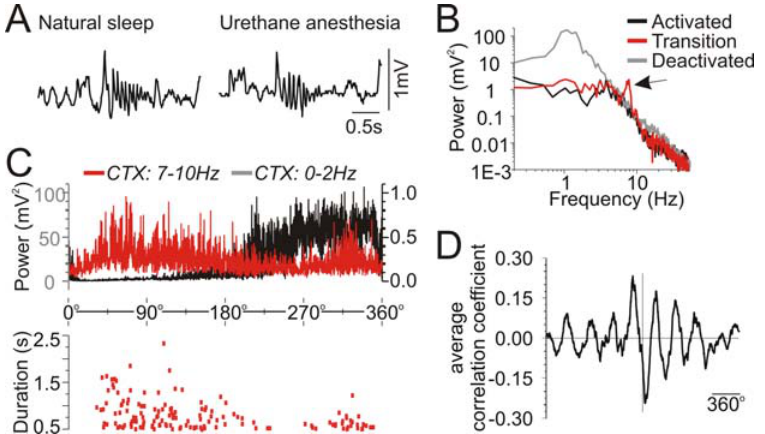
Figure 5. Transition phase between activated and deactivated patterns was characterized by cortical spindling across both natural sleep and urethane anaesthesia. A) An expanded example of a cortical spindle oscillation recorded during natural sleep (left) and a similar pattern recorded at the same electrode during the transition phase under urethane anaesthesia (right). B) Superimposed spectral plots of cortical EEG taken during activated, transition and deactivated states in a urethane-anaesthetized animal. Note the spectral peak in the transition spectra centered at , 8 Hz (spindle frequency). C) Superimposed spectrographic power at low (0 to 2 Hz: black) and spindle (7 to 10 Hz: red) frequencies (top panel), and the simultaneous occurrence and duration of spindles across the evolution of all state alternations for one full experiment (bottom panel). Note the augmented presence of spindling activity at the transition points between activated and deactivated patterns. D) Average (across all experiments) of the cross correlation function between 1 Hz and spindle (7–9 Hz) spectrographic power (n=5; standardized cycle in degrees). The temporal relationship of spindling to slow oscillatory activity at 1 Hz patterns showed a consistent lag of approximately half a period length ( , 180 degrees).